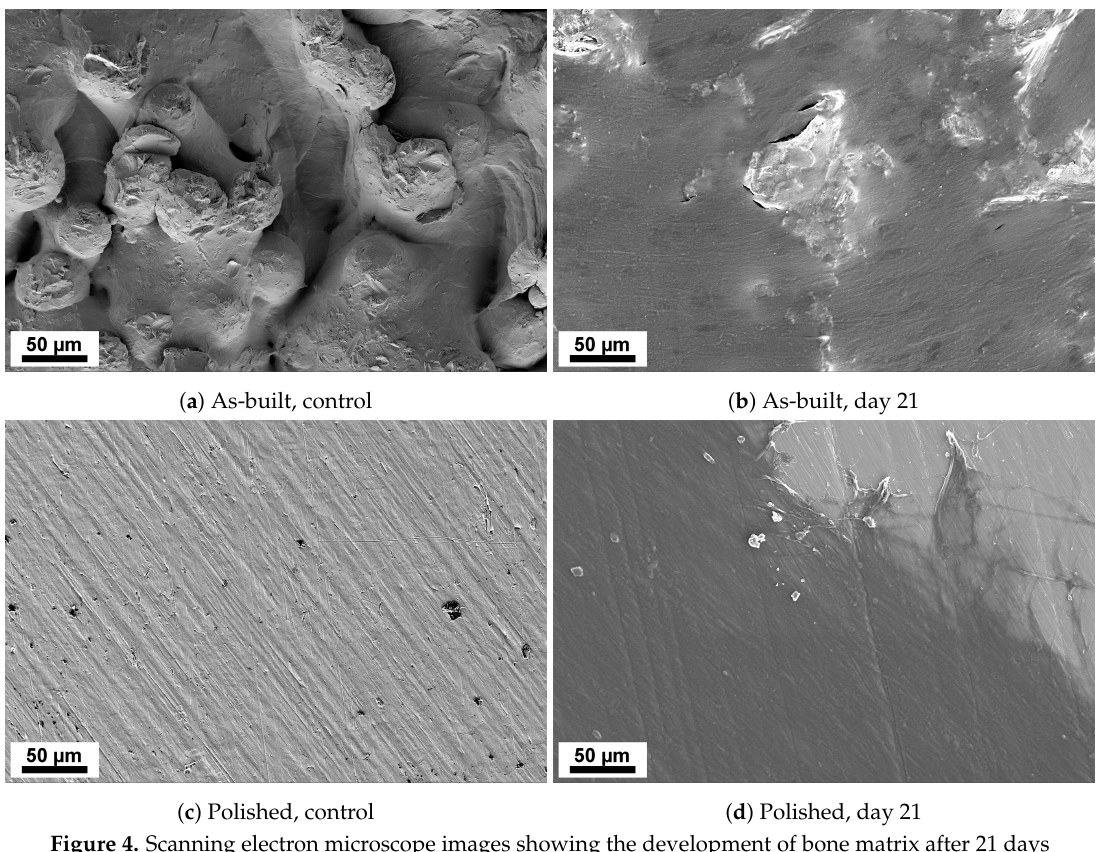
Figure 4. Scanning electron microscope images showing the development of bone matrix after 21 days of culturing with bone marrow-derived human mesenchymal stem cells. ( a , c ) Cell-free as-built and polished controls, respectively. ( b , d ) As-built and polished samples cultured with mesenchymal stem cells for 21 days, respectively